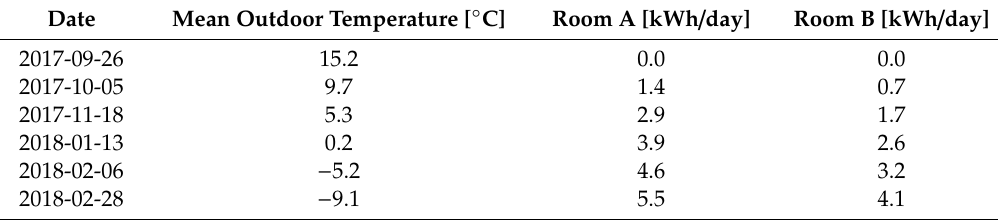
Table 2. Energy use in kWh / day per room at di ff erent mean outdoor daily